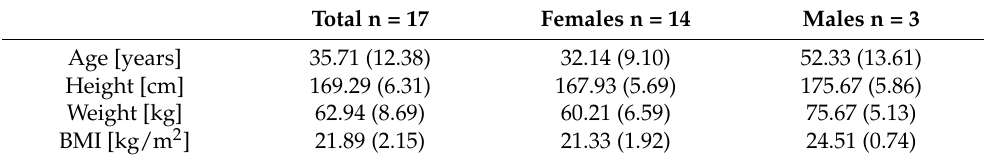
Table 1. Baseline characteristics of the participants by sex. Mean values with standard deviation (SD) in brackets are shown for the total characteristic group, and females and males. BMI indicates the body mass